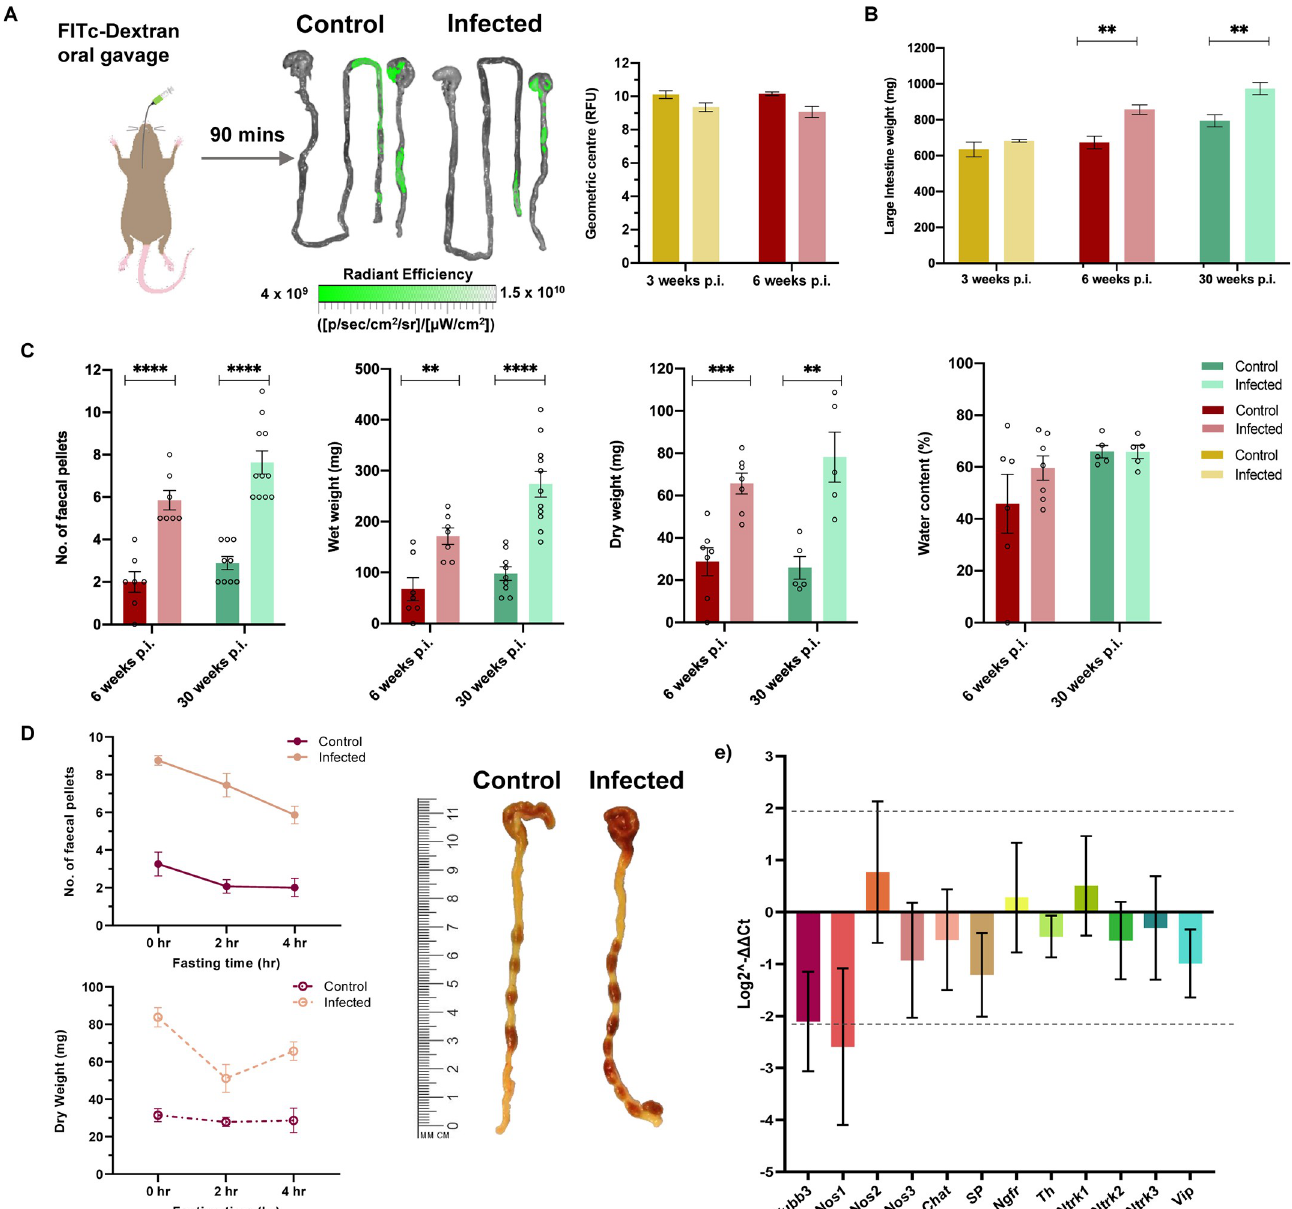
Fig 4. Evidence of colonic transit dysfunction in experimental digestive Chagas disease model. A. Schematic diagram of a mouse receiving oral gavage of a green fluorescent marker, FITC-conjugated 70 kDa dextran, 90 min prior to termination to trace large intestine transit delay during infection. Representative images of stomach, small and large intestine are superimposed with traces of FITC-dextran travelling through small into large intestine to show transit difference between control and TcI-JR C3H/HeN infected mice. Linear-scale pseudocolor heat map shows minimum and maximum fluorescence intensity of FITC-dextran. Bar plots show quantification of FITC-dextran fluorescence in the large intestine of mice at 3 ( n = 4 per group) and 6 ( n = 4 per group) weeks post-infection (p.i.). Fluorescence is expressed as geometric centre which is centre mass of the marker. B. Bar plot shows post-mortem weights of large intestine at 3 ( n = 4 per group), 6 ( n = 7 per group) and 30 (control n = 9, TcI-JR n = 11) weeks p.i. C. Faecal output analyses between control and TcI-JR C3H/HeN infected mice are expressed as faecal pellet count, wet and dry weight, and percentage of water content at 6 ( n = 7 per group) and 30 weeks p.i. ( n = 5–11 per group). D. Quantification of the effect of different fasting times on faecal output of mice: number of faecal pellets ( n = 4–16 per group) and dry faecal weight ( n = 4–7 per group). Images of mouse large intestine showing faecal impaction during infection at 30 weeks p.i. after 4 hours fasting compared to control. Scale bar is in cm and mm. Data are expressed as mean ± SEM. Statistical significance was tested using unpaired two-tailed Student’s t test ( �� P < 0.01; ��� P < 0.001, ���� P < 0.0001). E. RT-qPCR analysis show log2-fold change in RNA expression of neuronal markers, including pan-neuronal tubulin β -3 ( Tubb3 ), neurotransmitter production ( Nos1 , Chat , SP , Th , Vip ), neuronal growth factor receptors ( Ngfr , Ntrk1 , Ntrk2 , Ntrk3 ), and non-neuronal NOS isoforms Nos2 and Nos3 . RNA was from colon tissue of C3H/HeN na ï ve control and TcI-JR infected mice ( n = 5 per group, biological replicates). Data are expressed as Log2 - ΔΔ Ct ± SD. Dashed line represents mean ± 2SD based on distribution of na ï ve group